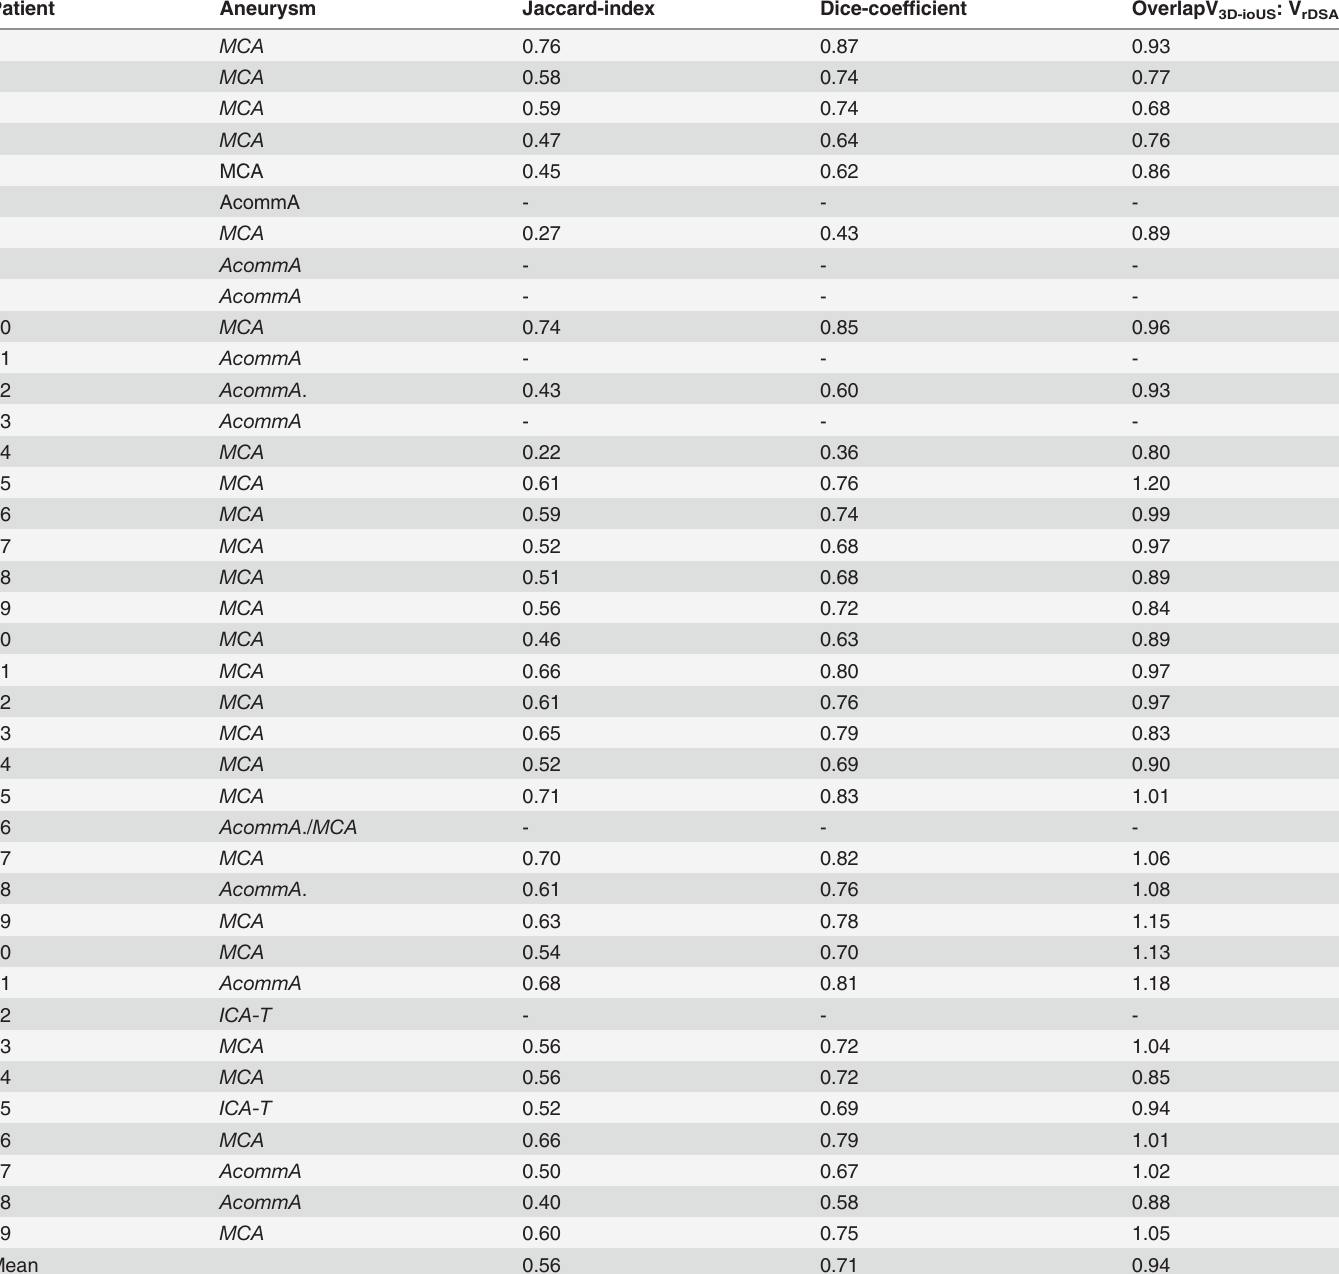
Table 2. Results of Dice-coefficient, Jaccard-Index and volume ratios for rDSA and 3D-ioUS volumes (Due to incomplete aneurysm visualization or absent aneurysm in the field of view patients 6, 8, 9, 11, 13, 26 and 32 were excluded from